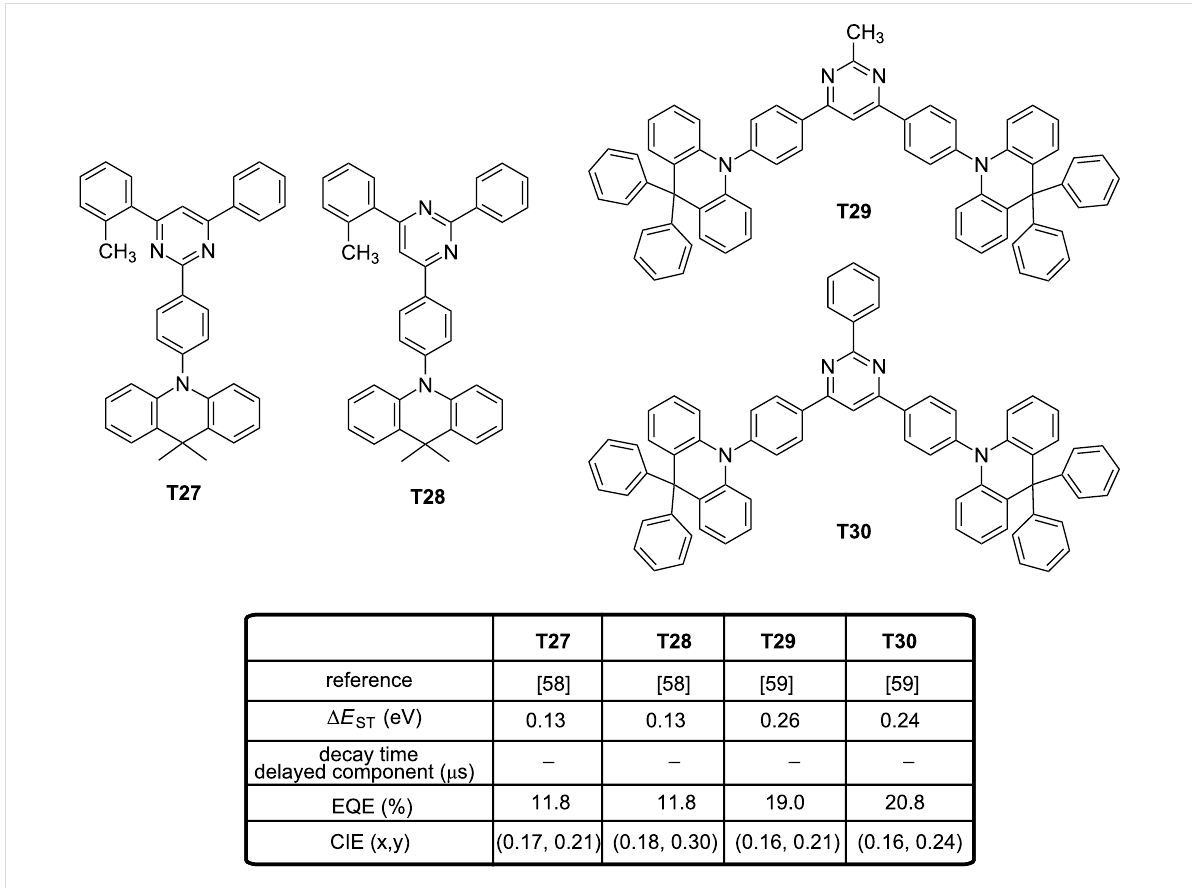
Figure 8: Pyrimidine-based TADF emitters T27 – T30